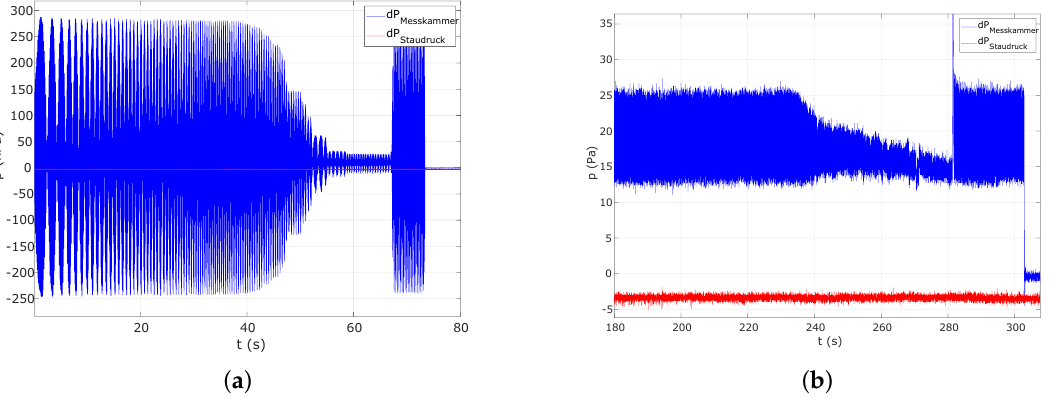
Figure 5. Measurement chamber investigation for reducing pressure oscillation introduced by the used pump. Blue Line—Pressure Oscillation in the mess chamber; Red Line—noise of the Ram Pressure sensor. ( a ) Differential pressure time series with different pipe cross-sections but without equalizing reservoir. Reduction from ± 275 Pa with initial setup down to ± 17 Pa at a flow rate of 12.5 L/min at 58 s. ( b ) Differential pressure time series with final equalizing reservoir and different pipe cross-sections. The pressure oscillation with the reservoir is about ± 7 Pa until second 230. Between 245 s and 281 s, the flow rate is reduced down to 17 L min − 1 with a pressure oscillation of ± 2.5